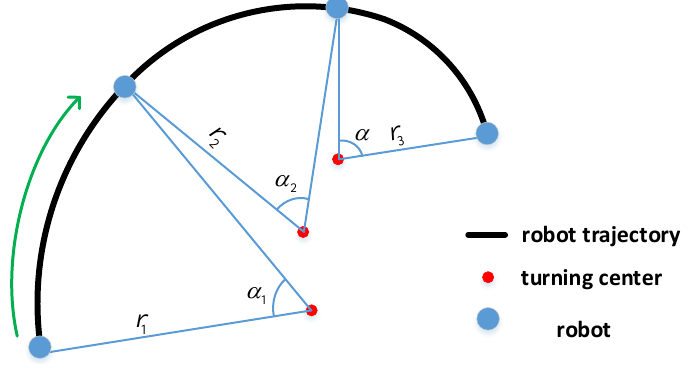
Figure 3. Different radii of the robot turning